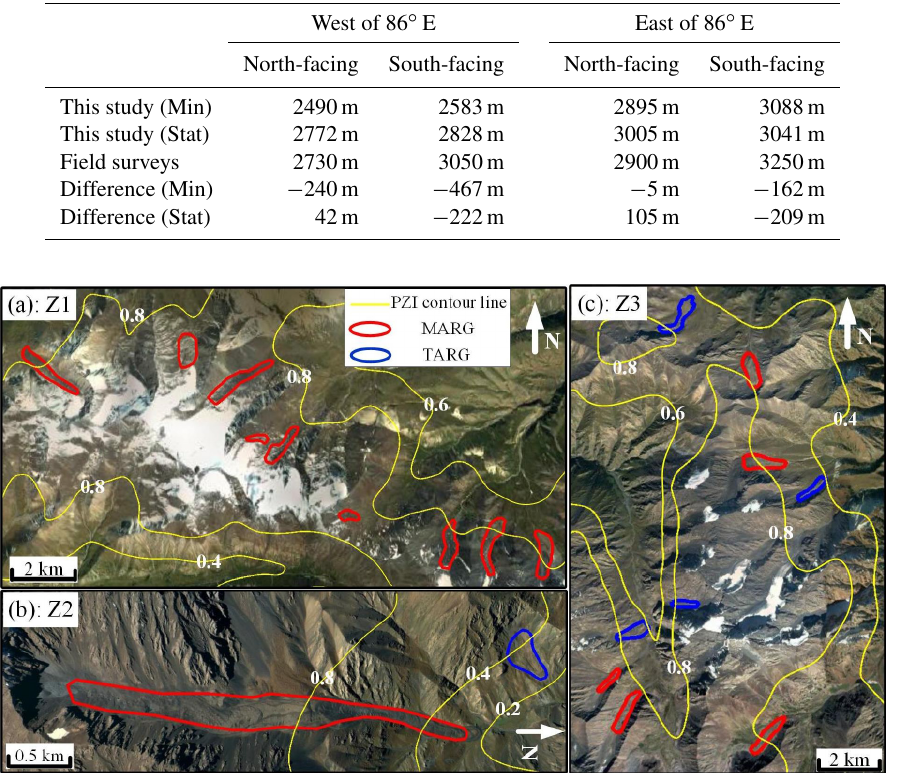
Figure 10. Local PZI maps for the three selected regions “Z1”, “Z2”, and “Z3” marked in Fig. 9b. (a) and (c) are selected randomly. (b) shows the MARG and TARG with the lowest FLP altitude within the entire study area. The thin yellow lines in (b–d ) are contour lines of PZI values. The red and blue polygons outline the MARGs and TARGs,